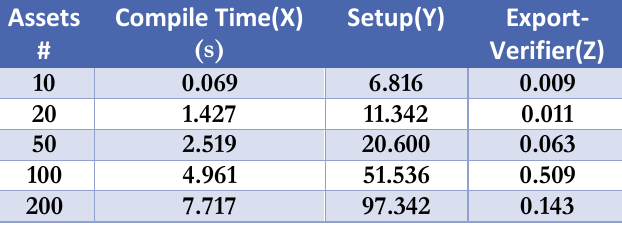
Table 3: Profiling Results for Verifier Assets